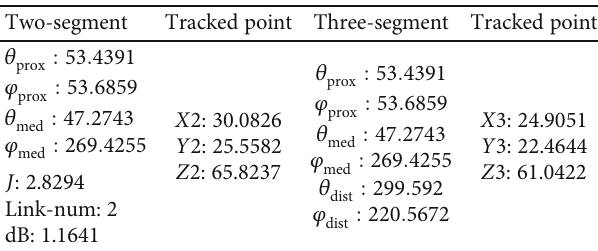
Table 8: Optimized results for three-segment catheter with variable length with interaction with fragile structures like texture. Two-segment Tracked point Three-segment Tracked